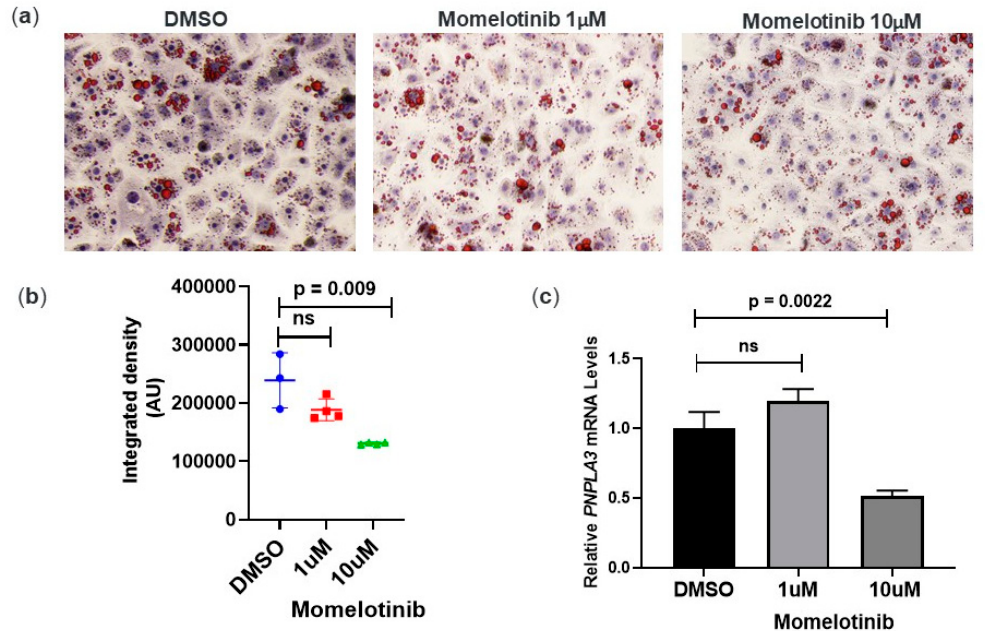
Figure 2. Momelotinib reduces neutral lipid staining in pHHs (148M/M). ( a ) Representative image of pHHs treated for 18 h with DMSO or momelotinib, 1 µ M and 10 µ M. Intracellular lipid droplets were visualized by oil red O (ORO) staining. Nuclei were counterstained in blue. ( b ) The average intensity of ORO staining was determined with Image J software using 3–4 images per treatment. An unpaired t -test was performed on resulting data. ( c ) Corresponding reduction in PNPLA3 mRNA was determined by qPCR. Average values from triplicate wells are shown, along with SD. Only the 10 µ M momelotinib treatment resulted in a significant reduction of PNPLA3 mRNA, based on one-way ANOVA.